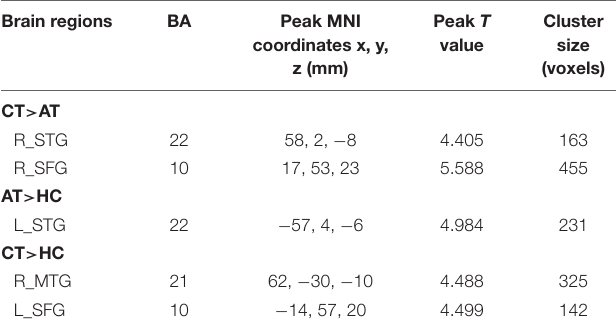
TABLE 2 | Brain regions with significant group differences in normalized CBF with GMV correction. Brain